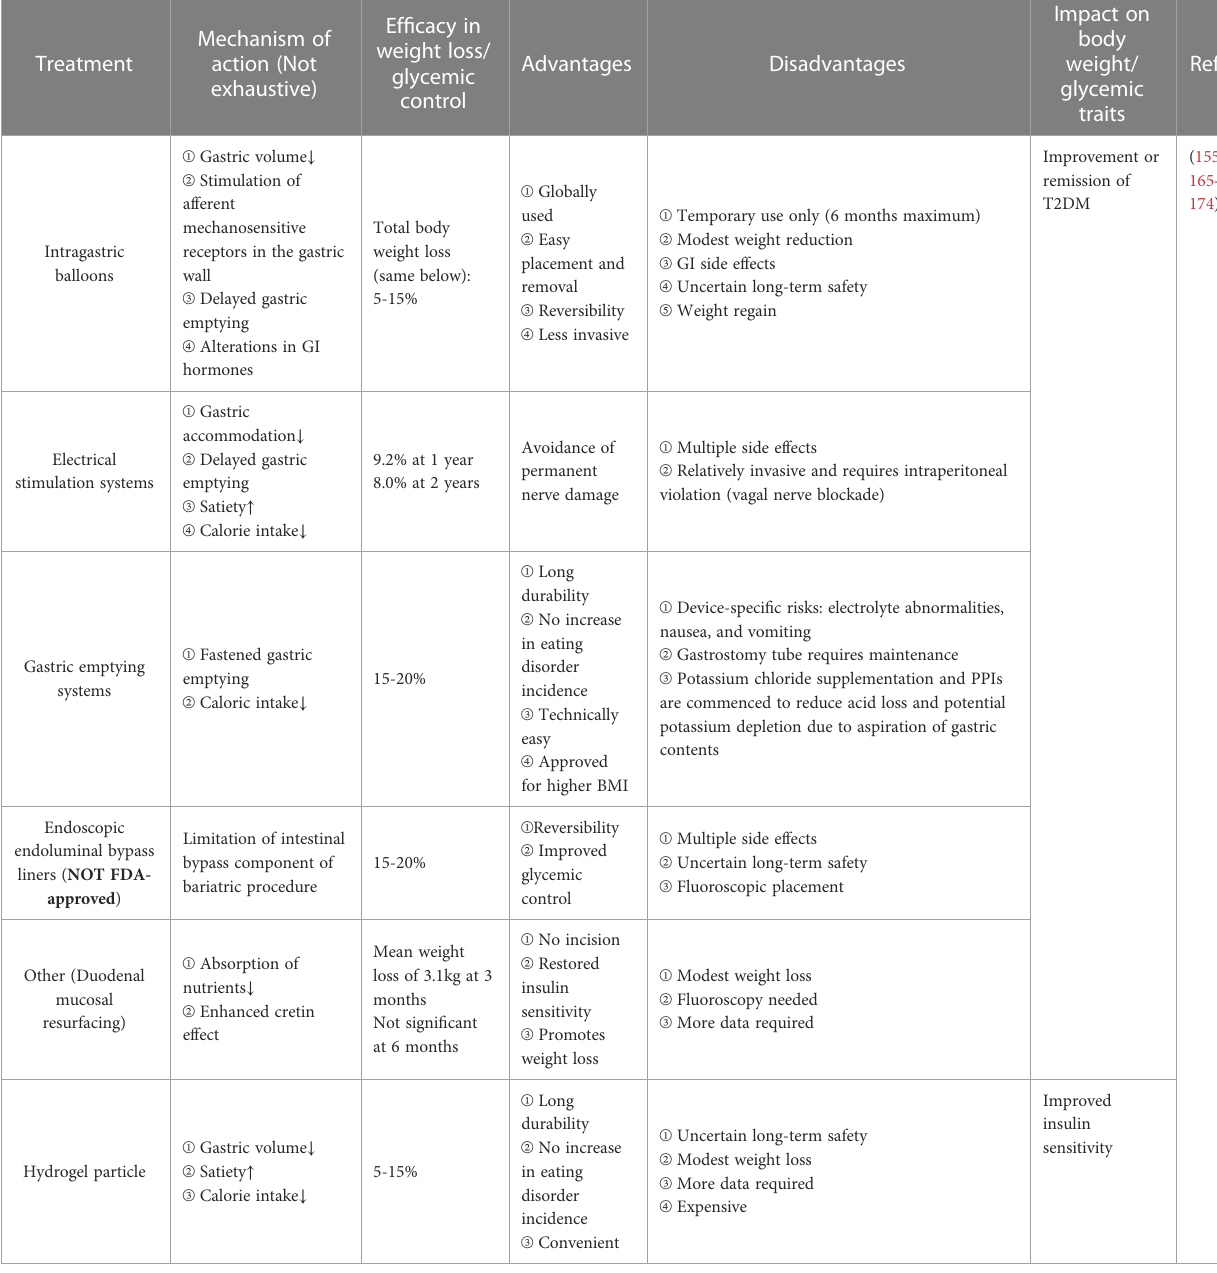
TABLE 2 The effects of medical devices on managing obesity and DM.